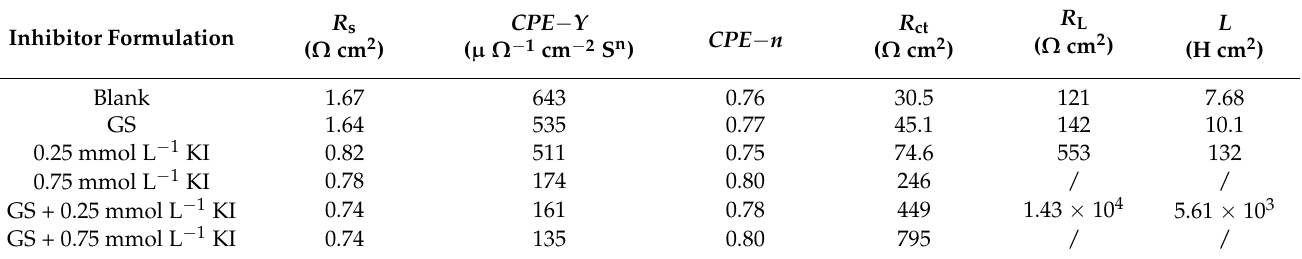
Figure 6. EEC to fit the EIS data for the electrodes in 0.5 mol L − 1 H 2 SO 4 solution with different corrosion inhibitor formulations. Table 5. EIS fitting results for the electrodes in 0.5 mol L − 1 H 2 SO 4 solution with different corrosion inhibitor formulations.